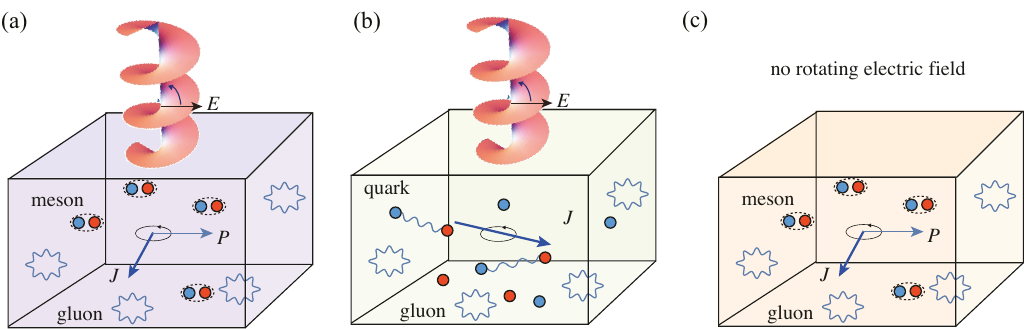
Figure 2 . Schematic illustration of the states in the phase diagram (cid:12)gure 3. (a) Insulator phase: only mesons and gluons can be excited since the quark-antiquarks are gapped. Vacuum polarization is induced as a collective excitation of mesons and follows the external rotating electric (cid:12)eld. This induces a non-dissipative rotating current, i.e., polarization current, in the xy -plane with no Joule heating. (b) Conductive phase: gapless excitation of quarks and antiquarks is possible and a current is induced by the external (cid:12)eld. The current is dissipative with (cid:12)nite Joule heating. (c) Vector meson Floquet condensate: an insulator solution that has a coherently rotating current even when the external electric (cid:12)eld is